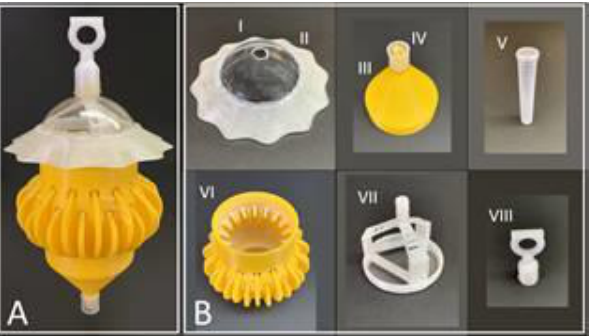
Figure 1. Stem trap. ( A ) Assembled stem trap used for the study. ( B ) Parts of the stem trap: I. Semi- circular, clear, plastic dome with an aperture at the top; II. Rain skirt; III. Funnel structure; IV. Funnel outlet for connecting the cap of the capture vial; V. Capture vial; VI. Body of the trap with stem-like protrusions on the outer surface leads to entry holes to guide ACPs into the trap ’ s interior; VII. Tripod structure; and VIII. Hanging nut used to deploy the trap and connect the tripod structure with the dome.